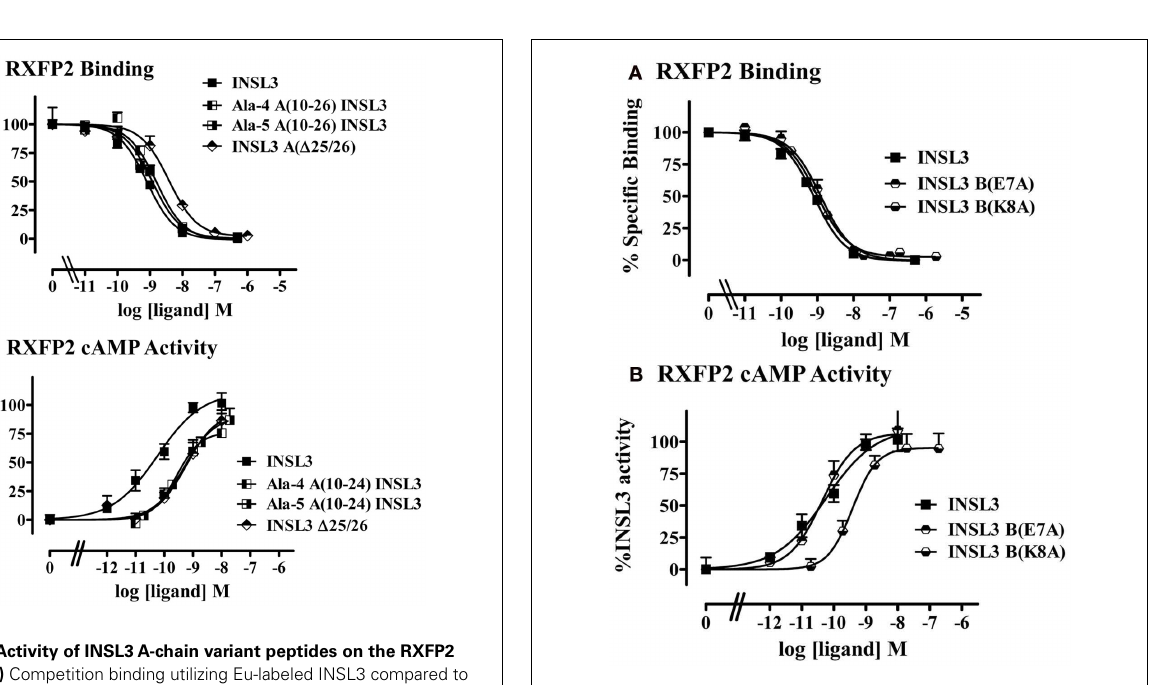
FIGURE 6 |Activity of INSL3 B-chain variant peptides on the RXFP2 receptor. (A) Competition binding utilizing Eu-labeled INSL3 compared to INSL3 and H2 relaxin. Data are expressed as the percentage of specific binding and are pooled from at least three experiments with triplicate determinations within each assay. (B) cAMP activity compared to INSL3 and H2 relaxin measured utilizing a pCRE– β -galactosidase reporter gene assay. Data are expressed as the percentage INSL3 maximum activity and are pooled data from at least three experiments with triplicate determinations within each